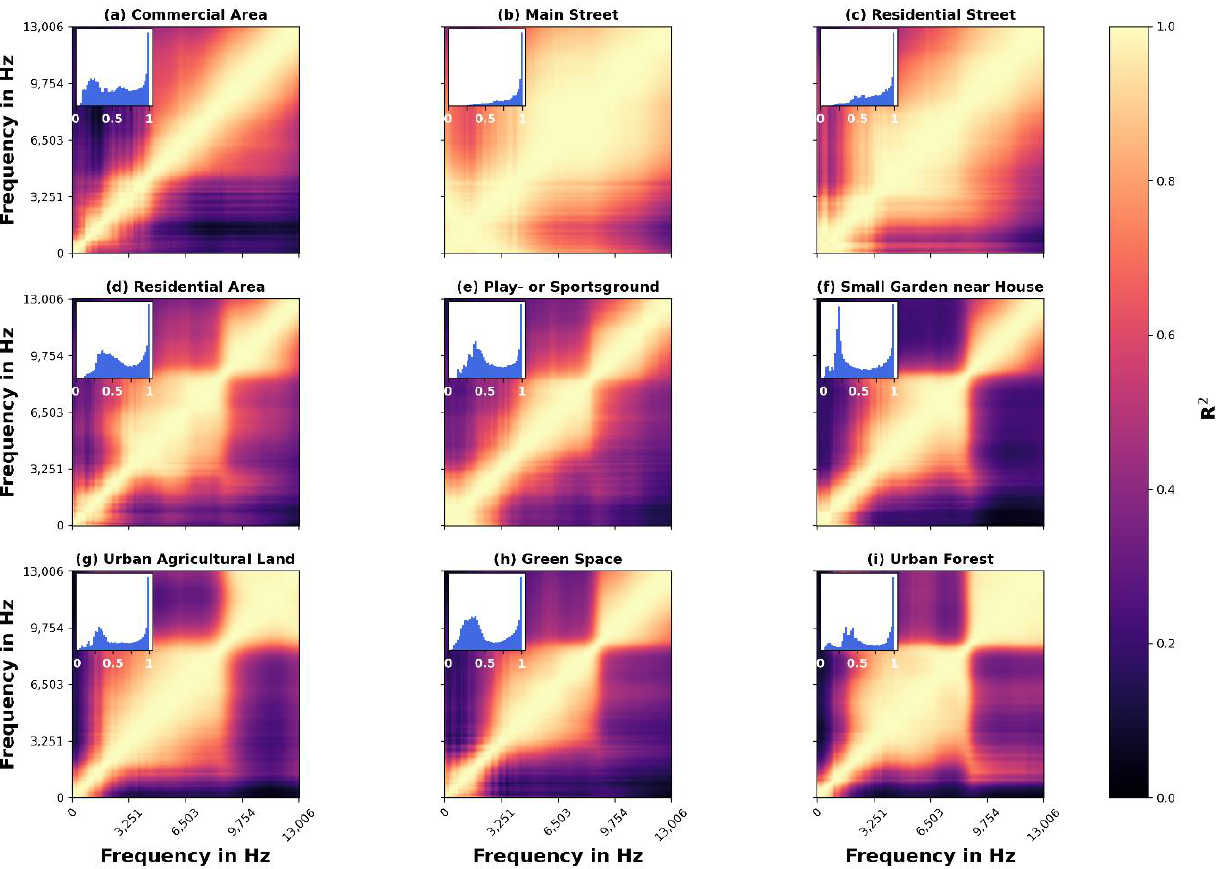
Figure 5. Frequency correlation matrices (FCMs) for all recordings over time, grouped by LUT ( a – i ). Here, the power spectra of each recording were correlated over time to identify temporally related frequency patterns. The Z-axis represents the squared Pearson correlation coefficient R 2 . The insert shows the distribution of all R 2 values of the respective correlation matrix (diagonal 1s caused by correlating the frequency bin with itself were removed for this purpose).